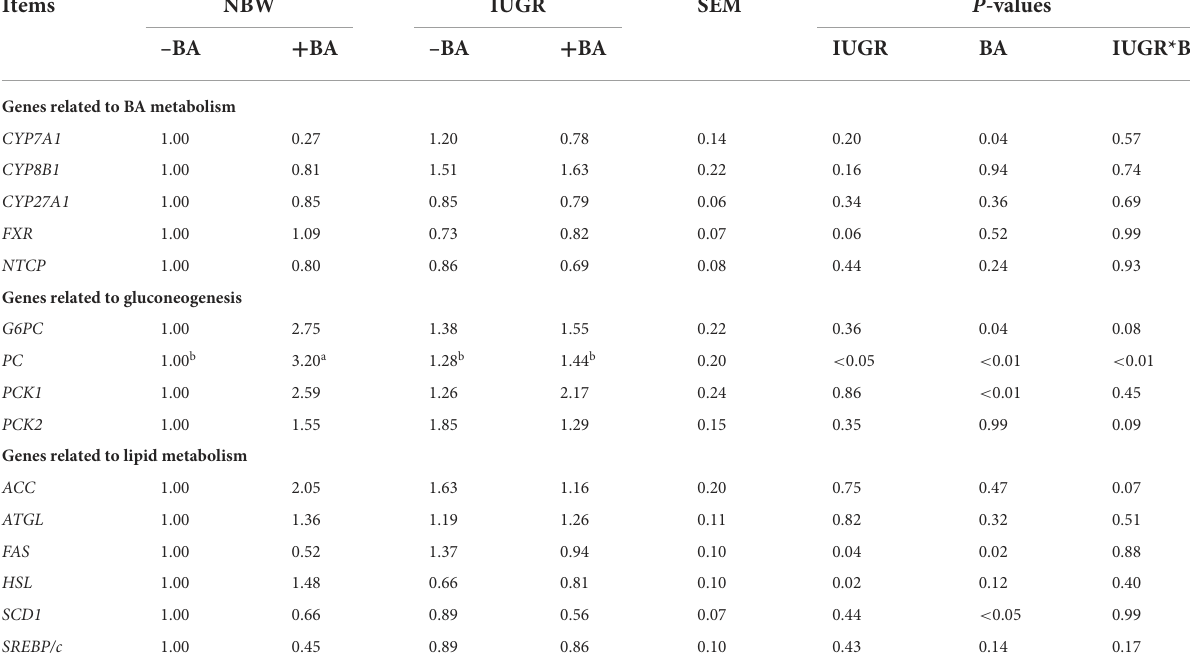
TABLE 9 Effects of dietary bile acid (BA) supplementation on liver BA, glucose, and lipid metabolism-related gene expressions in weaned piglets with NBW and IUGR. Items NBW IUGR SEM P -values